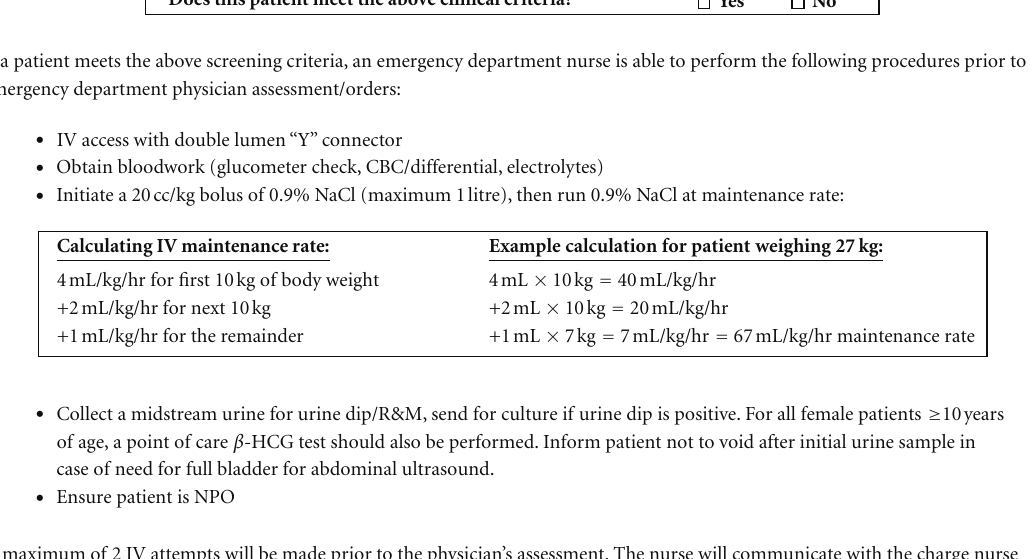
Figure 4: Alberta Children’s Hospital Advanced Nursing Directive for Children with Suspected